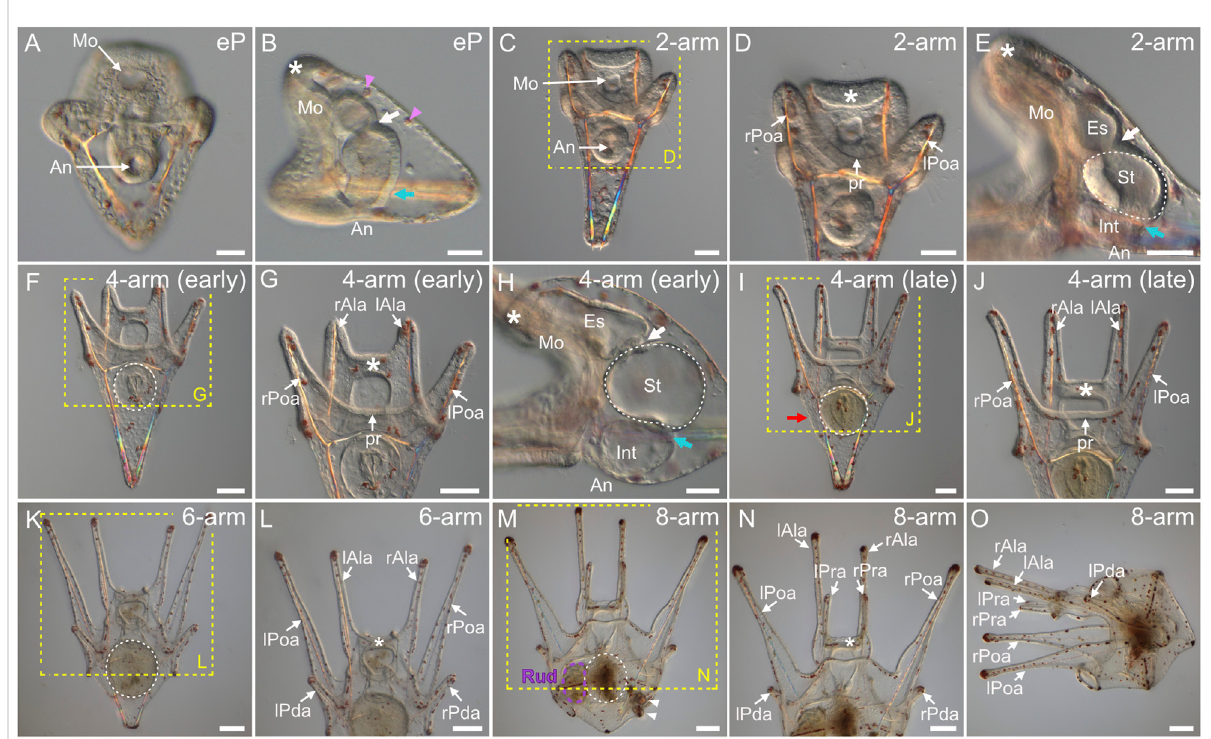
FIGURE 7 Paracentrotus lividus larval development under light microscopy. Developmental stages are as follows: (A,B) early pluteus stage (eP); (C – E) 2- arm pluteus stage (2-arm); (F – J) 4-arm pluteus stage (4-arm); (K,L) 6-arm pluteus stage (6-arm); (M – O) 8-arm pluteus stage (8-arm). The use of (early)and(late)associatedwiththestagenamessimplyhighlightsheremorespeci fi cperiodsduringthe4-armpluteusstage.In (A,C,D,F,G,I – N) ,the larvae are in anterior view with the ventral side up. In (B,E,H,O) , the larvae are in left view, with the ventral side left and the anterior side up. In (B,D,E,G,H,J,L,N) , the asterisk marks the oral hood located above the mouth. In (B,E,H) , the white arrow indicates the cardiac sphincter separating the esophagus and the stomach, and the cyan arrow marks the pyloric sphincter separating the stomach and the intestine. In (B) , pink arrowheads highlight red-pigmented cells present within the dorsal ectoderm. In (D,G,J,L,N) , the images correspond to close-ups of the regions outlined by yellowboxesin (C,F,I,K,M) ,respectively.In (E,F,H,I,K,M) ,thewhitedottedlineoutlinesthestomach.In (I) ,theredarrowdesignatesthelarvalstomach region. In (M) , the purple dotted line highlights the adult rudiment, and white arrowheads mark the pedicellariae. Scale bar: (A – E,H) 30 μ m; (F,G,I,J) 50 μ m; (K – O) 100 µm. An: anus; Es: esophagus; Int: intestine; lAla: left anterolateral arm; lPda: left posterodorsal arm; lPoa: left postoral arm; lPra: left preoral arm; Mo: mouth; pr: postoral region; rAla: right anterolateral arm; rPda: right posterodorsal arm; rPoa: right postoral arm; rPra: right preoral arm; Rud: adult rudiment; St: